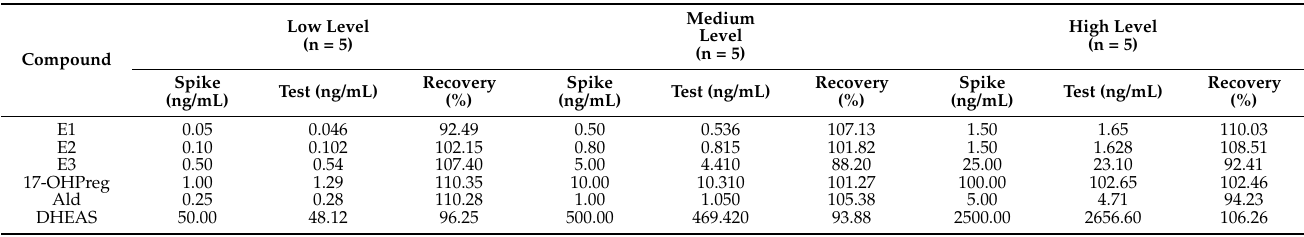
Table 4. The results of recoveries of different compounds.